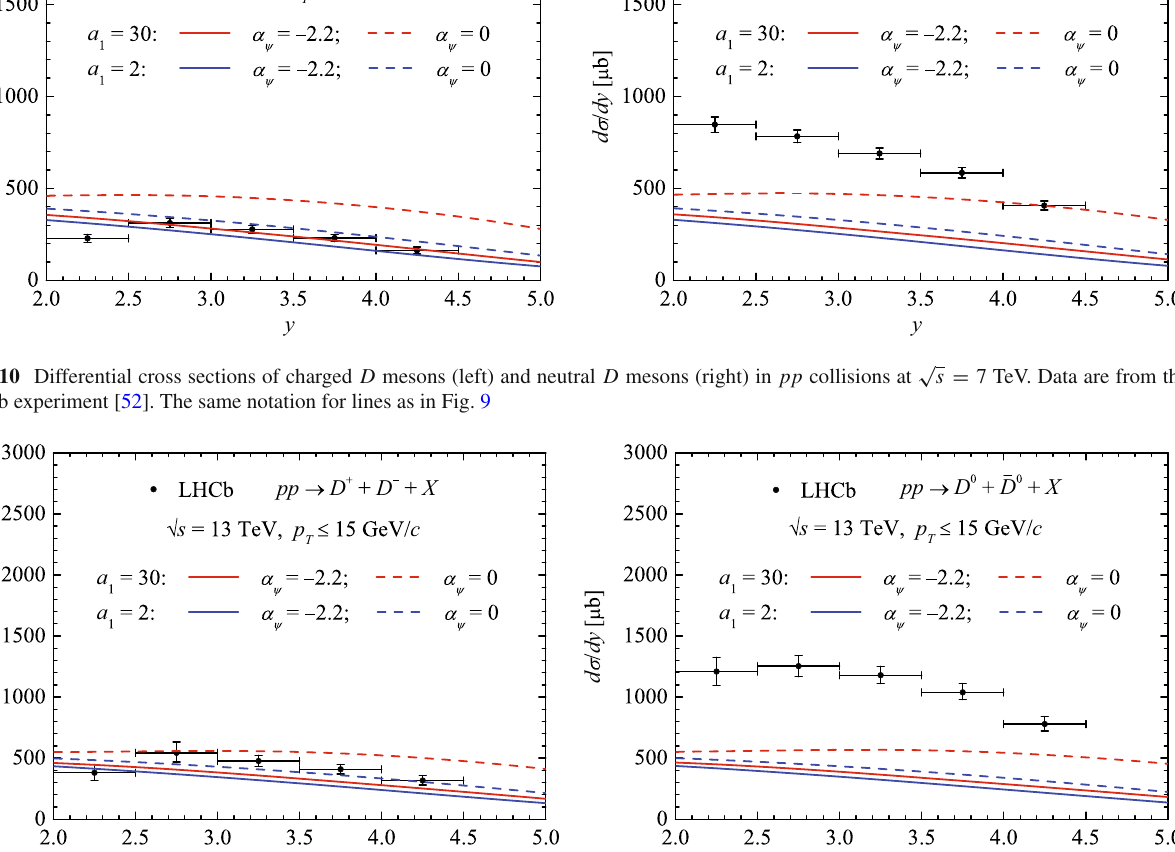
√ s = 13 TeV. Data are from the